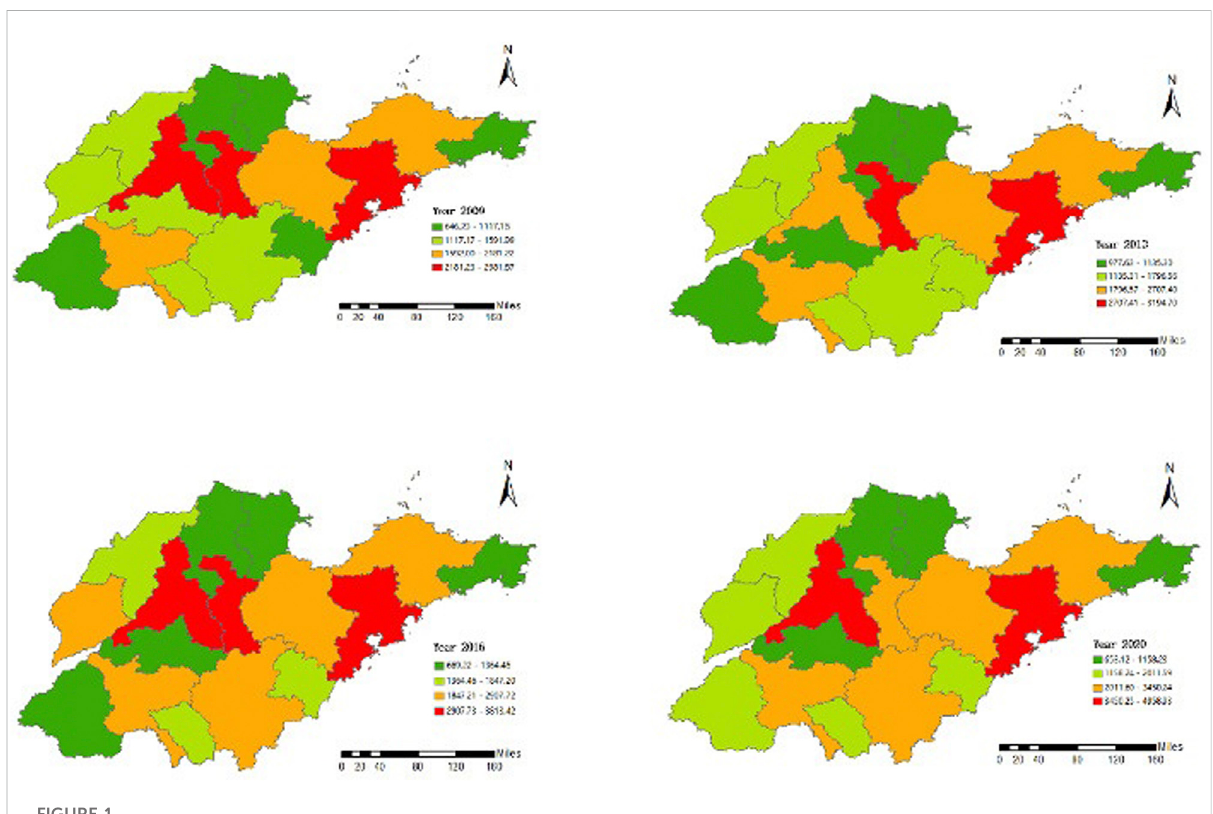
FIGURE 1 Carbon emissions of 16 cities in 2009, 2013, 2016, and